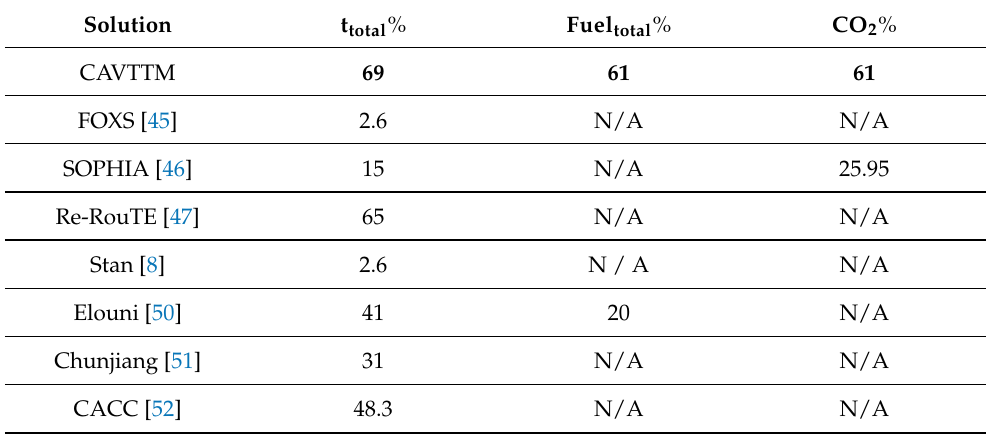
Table 14. Comparison of vehicular traffic congestion reduction